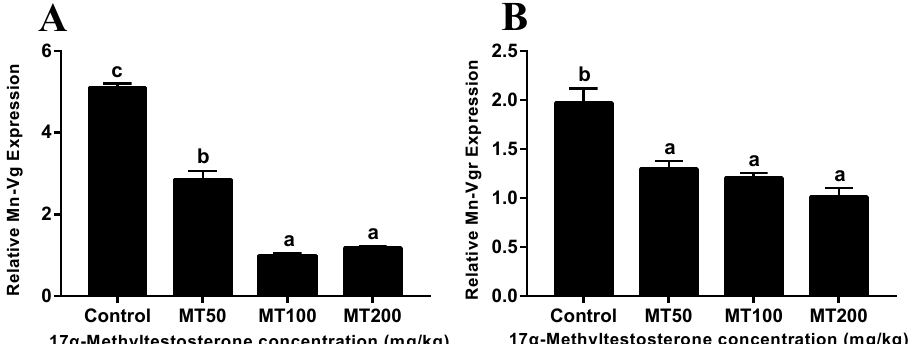
Figure 5. Expression characterization of Mn-Vg and Mn-Vgr in female prawns treated with different concentrations of MT for 40 days. ( A ) Expression levels of Mn-Vg in female prawns treated with different concentrations of MT for 40 days; ( B ) expression levels of Mn-Vgr in female prawns treated with different concentrations of MT for 40 days. The amount of Mn-Vg and Mn-Vgr mRNA was normalized to the EIF transcript level. Data are shown as mean ± SEM of whole prawns from separate individuals in the same group (n = 3). Lowercase letters indicate the difference in expression between di ff erent samples.